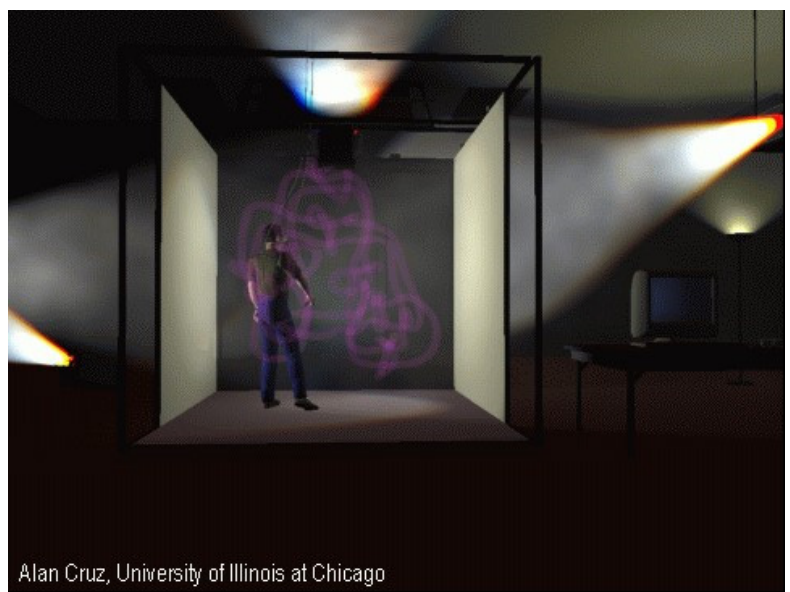
Figure 11. The 1992 CAVE™ illustration, courtesy of the Electronic Visualisation Laboratory (EVL), University of Illinois, Chicago (CAVE is a trademark of the University of Illinois Board of Trustees). VR continues to be a rapidly expanding field. Today, the artistic use of such immer- sive, augmented, and extended technologies is also increasing and becoming more com- mon in mainstream museums and galleries, hastened and intensified by challenges pre- sented by the COVID-19 pandemic.